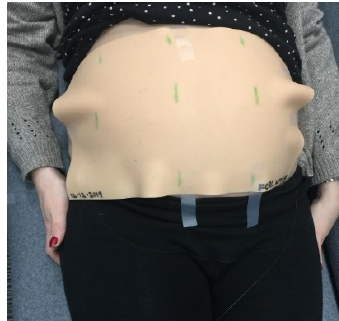
Figure 3. Position of FBG sensor array membrane on volunteer’s abdomen during experiments.